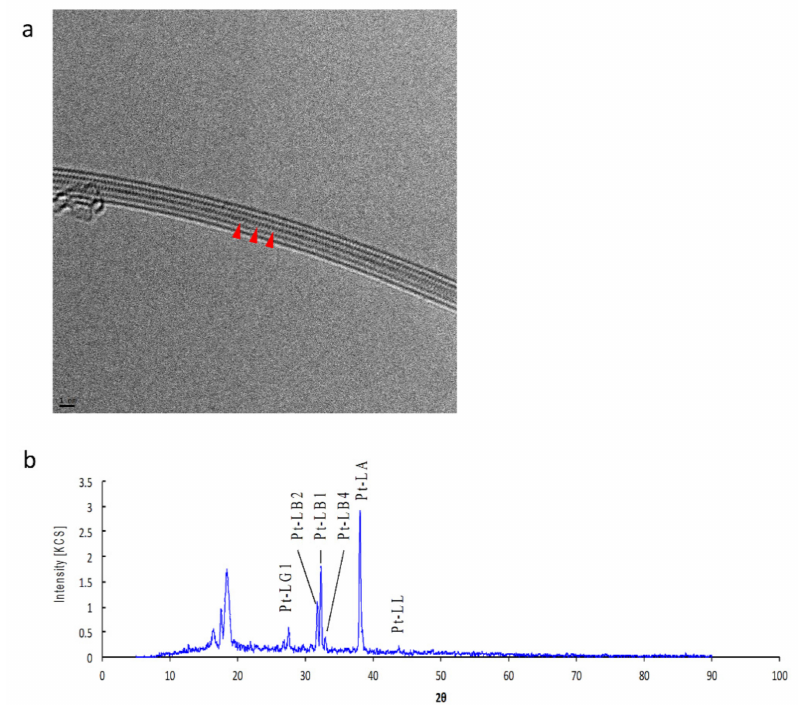
Figure 1. Transmission Electron Microscopy (TEM) image and X-ray fluorescence (XRF) spectrum of platinum(Pt)-peapods: ( a ) In the TEM image, the hollow structure of carbon nanotubes (CNTs) was filled with platinum (II) chloride (PtCl 2 ) molecules (red arrow). Scale bar: 1 nm. ( b ) From the XRF spectrum, the Pt content was about 2 wt%, which was approximately the same as the theoretical